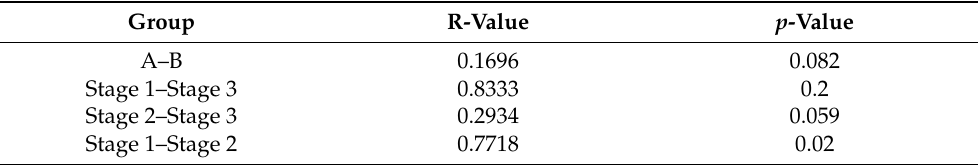
Table 3. ANOSIM analysis of differences between groups.